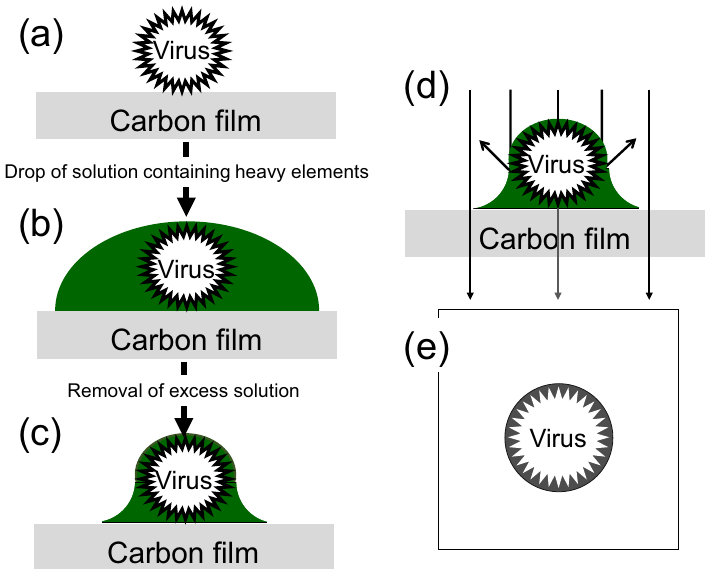
Figure 1. Negative staining method. ( a ) Virions are attached to the carbon support film. ( b ) A solution containing heavy metals (negative-staining reagent) is dropped onto the film. ( c ) Excess solution is removed, and the sample is dried. ( d ) Transmission electron microscopy (TEM) of heavy-metal-coated virions produces ( e ) a reverse-contrast image of the virus.